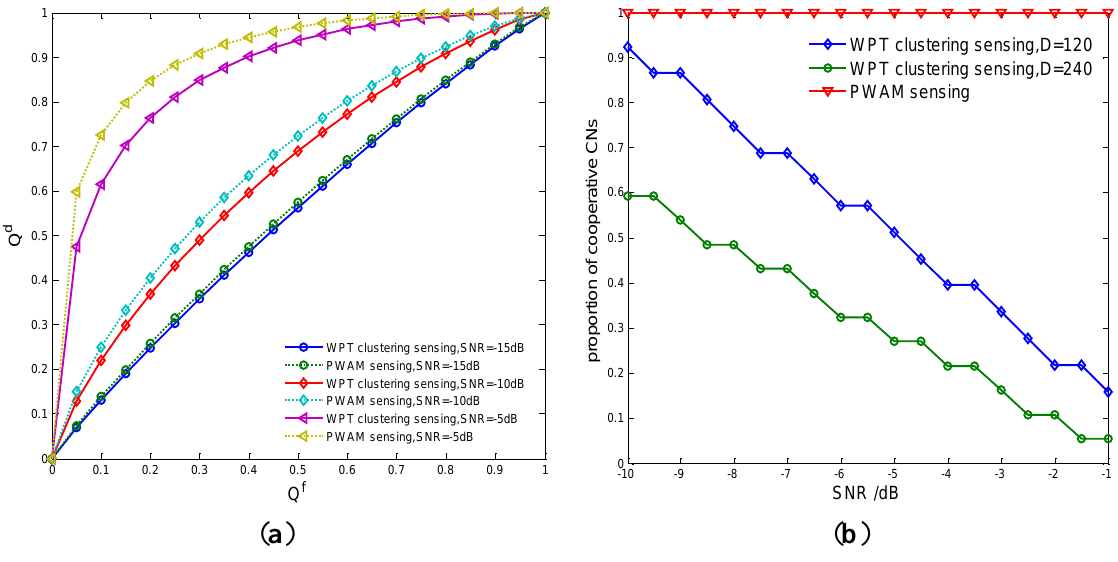
Figure 10. Performance comparison of different sensing methods. ( a ) Detection probability; ( b ) Proportion of cooperative